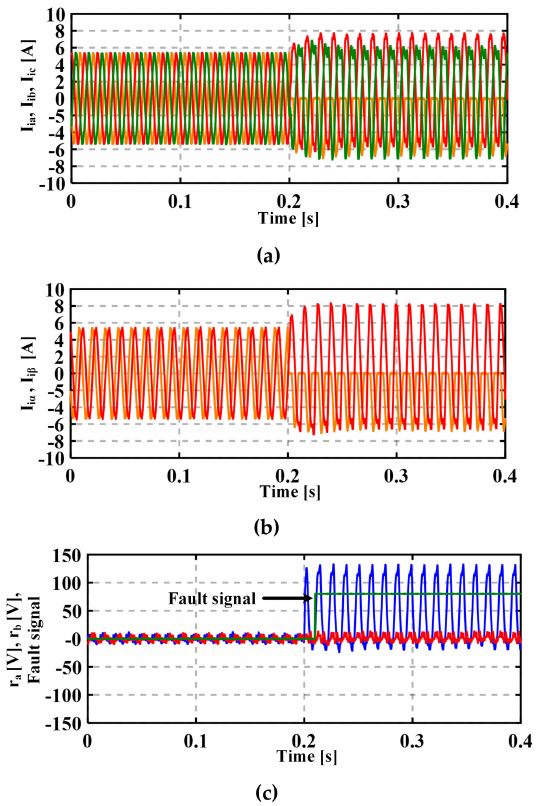
Figure 8. Experimental results: Open-switch fault on Q 1 at 0.2 s. ( a ) Filter currents of the three phases I ia (yellow), I ib (red), I ic (green); ( b ) filter currents in the stationary reference frame i i α (yellow), i i β (red); ( c ) residual errors r α (blue), r β (red), and fault signal